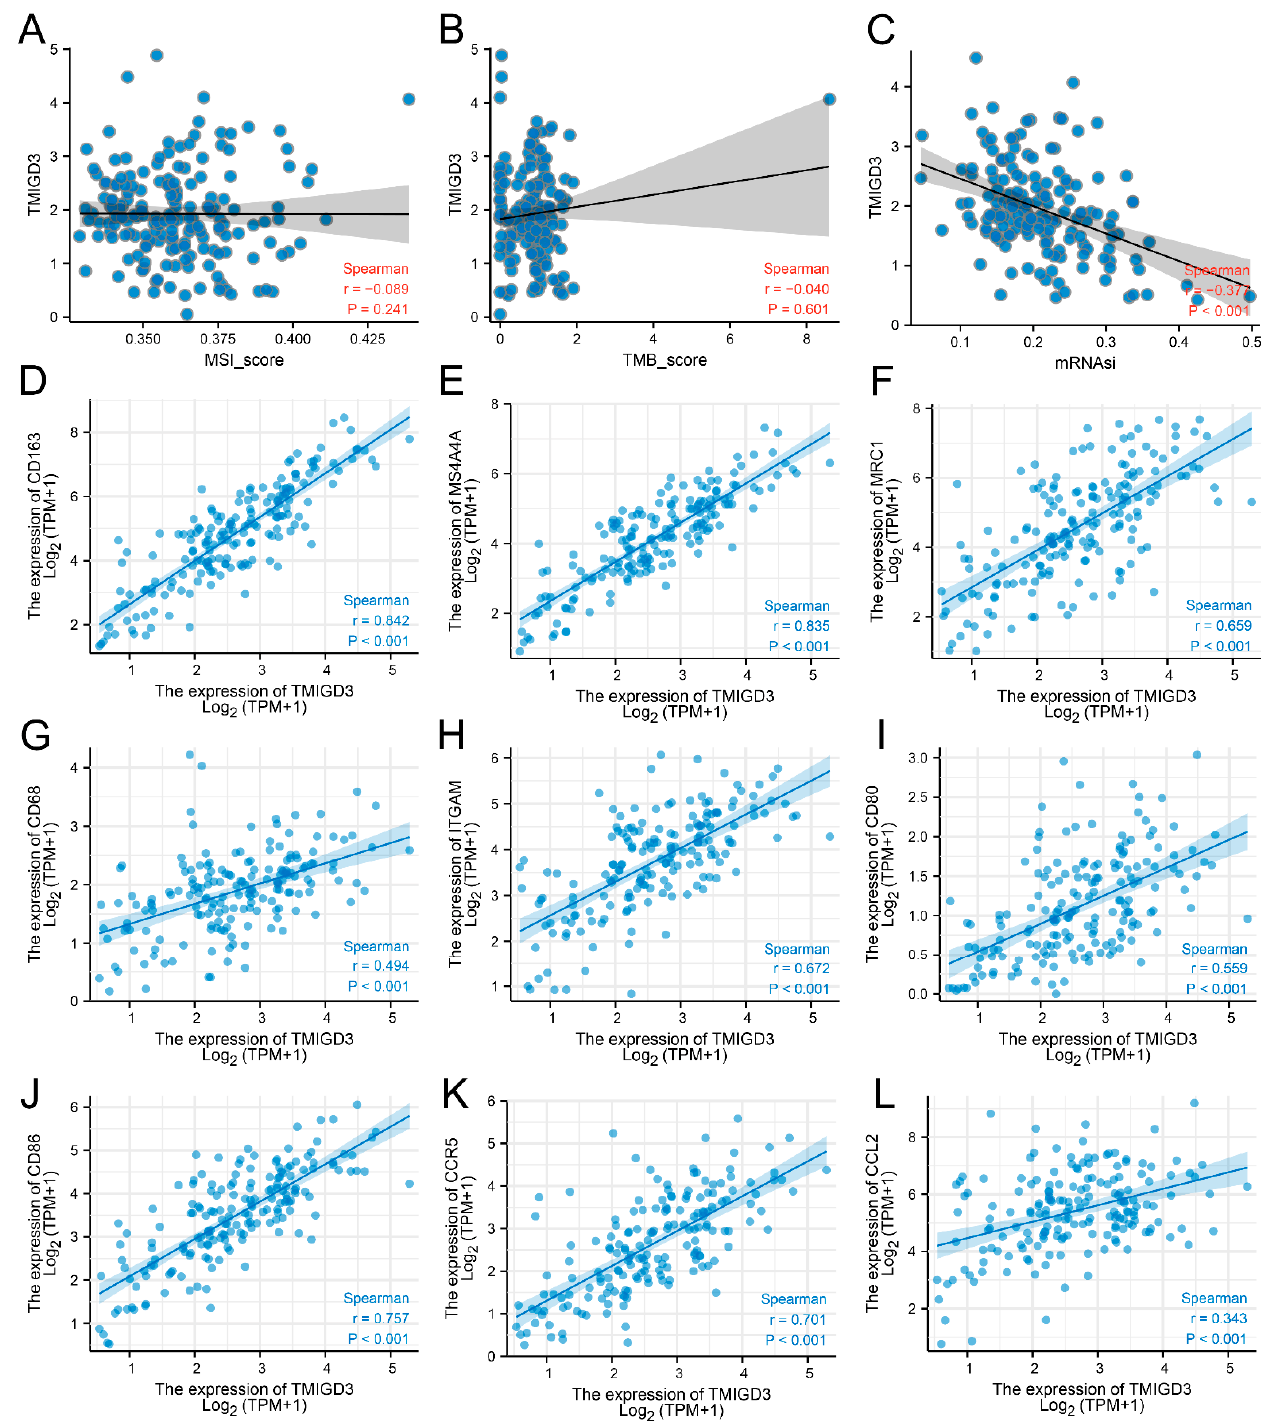
Figure 6. TMIGD3 is associated with the marker of macrophages. Notes: ( A – C ) Correlation